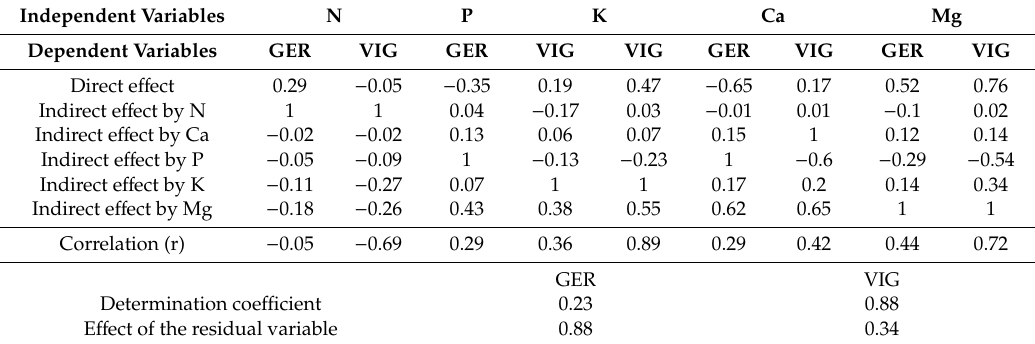
Table 2. Estimates of direct and indirect e ff ects involving the key dependent variables of germination and vigor, and the other independent explanatory variables as